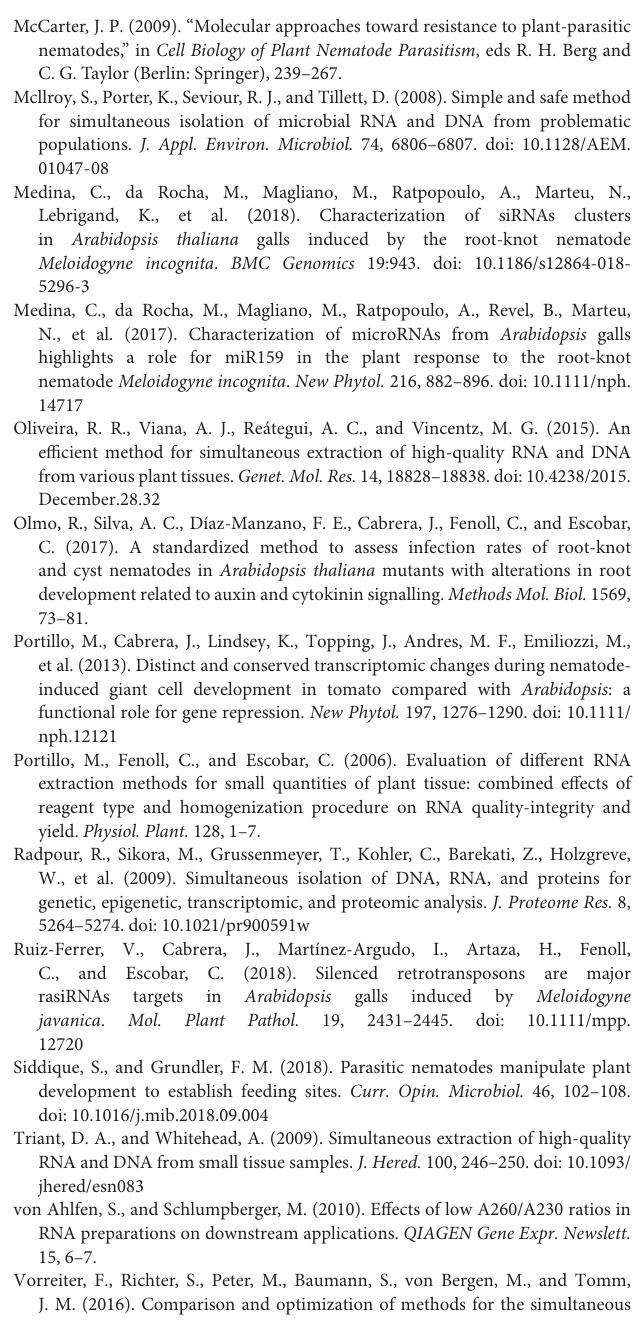
DEHYDROGENASE C2 ; AT1G13440), used frequently as a normalizer for qRT-PCR. 12.5 ng of the initial total RNA from galls was used in each of the three technical replicates (1–3) for the two tested genes. The corresponding cDNAs were amplified with the primers in Supplementary Table S1 and single clean amplicon bands (60 bp in the case of CMT2 and 86 bp in the case of GAPC2 ) can be observed. Ethidium bromide-stained agarose gel electrophoresis. NTC, No TABLE S1 | List of primers used for